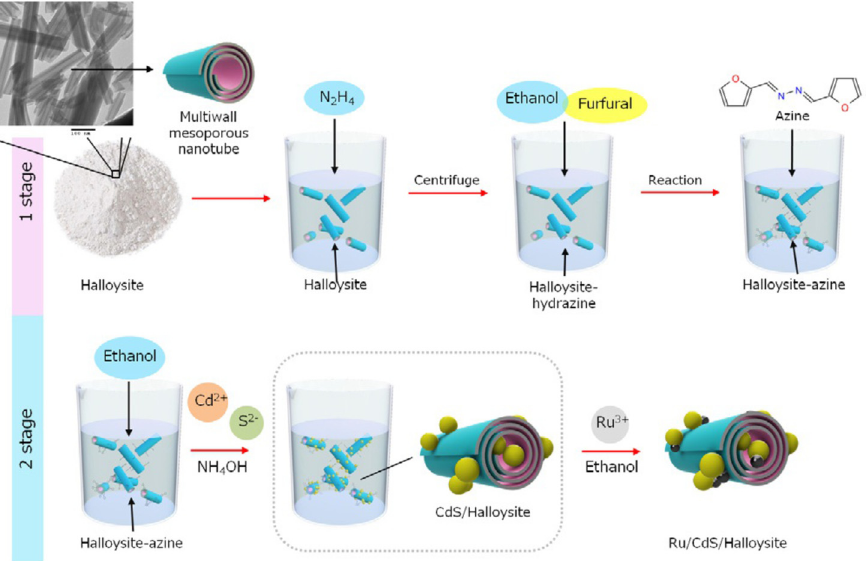
Figure 7. General procedure for preparation of Ru/CdS/halloysite photocatalysts. Reproduced with permission from ref. [87]. Copyright 2020 John Wiley and